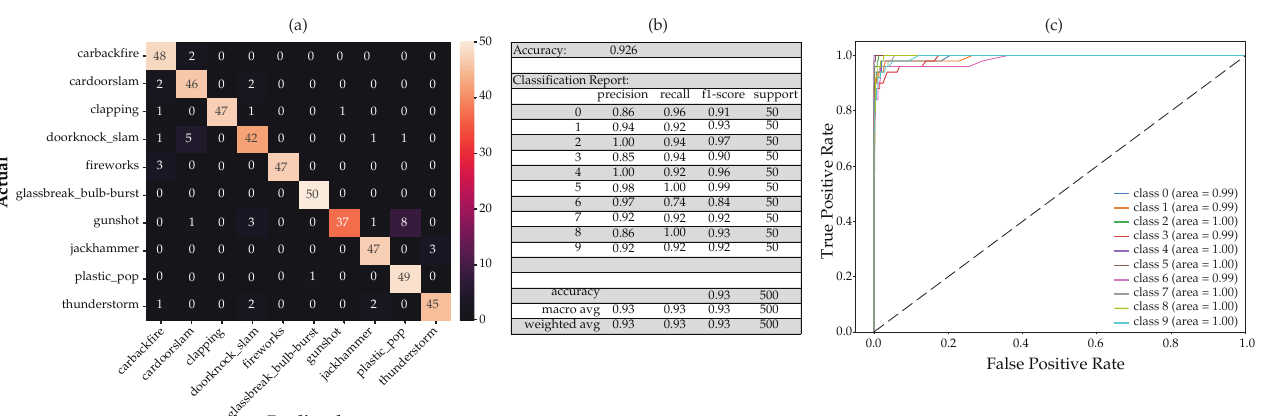
Figure 14. The generated model using only the first 20 features according to the MDI feature importance analysis, showing the resulting: ( a ) confusion matrix, ( b ) classification report and, ( c ) ROC curves.